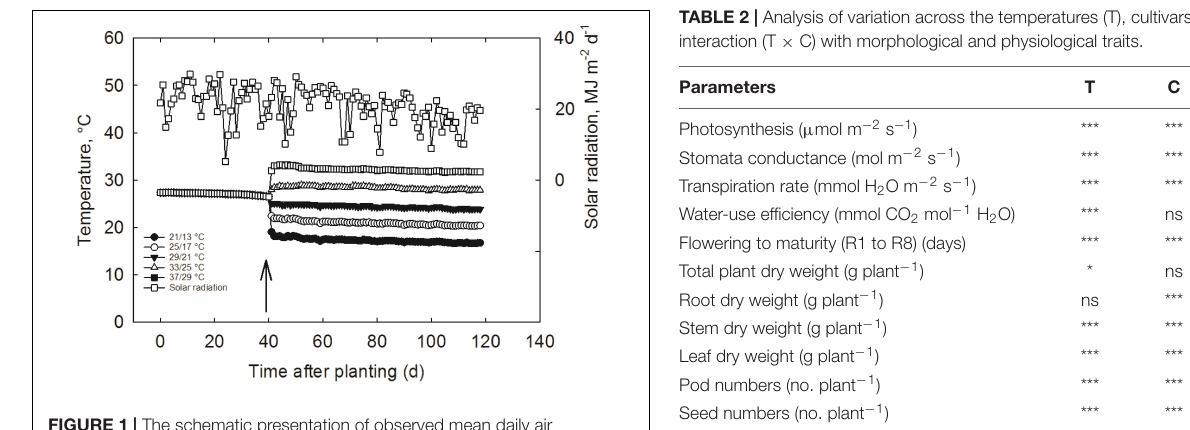
FIGURE 1 | The schematic presentation of observed mean daily air temperature and solar radiation levels during the experiment. The upward arrow on the panel indicates the date on which temperature treatments were imposed. TABLE 1 | The set treatments and observed mean of the daily measured chamber (CO 2 ), temperature, vapor pressure deficit (VPD), and evapotranspiration (ET) during the experimental period. Set Measured parameters treatments